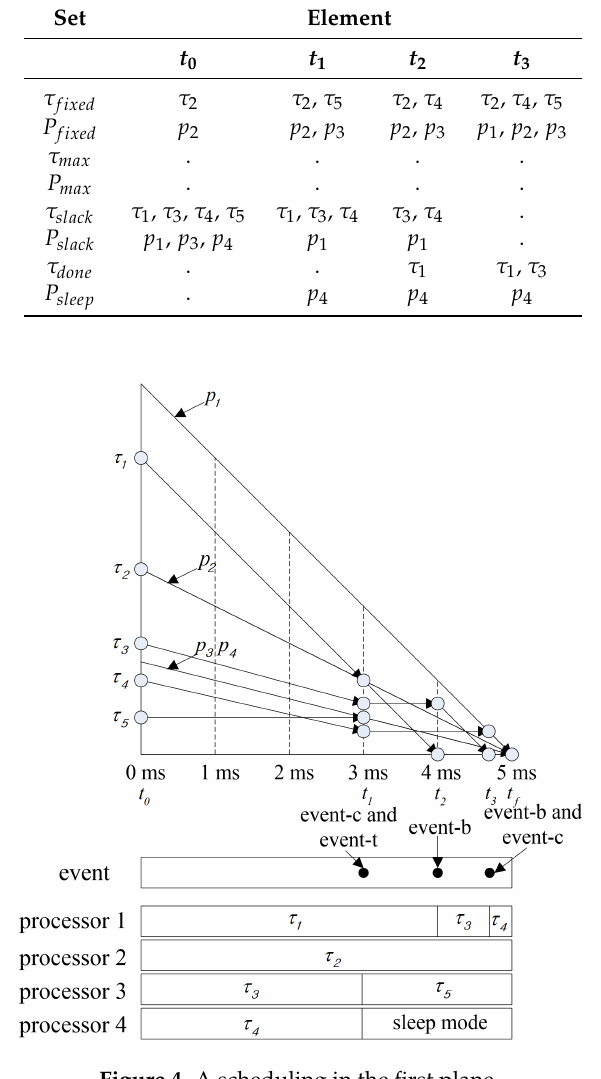
Figure 4. A scheduling in the first